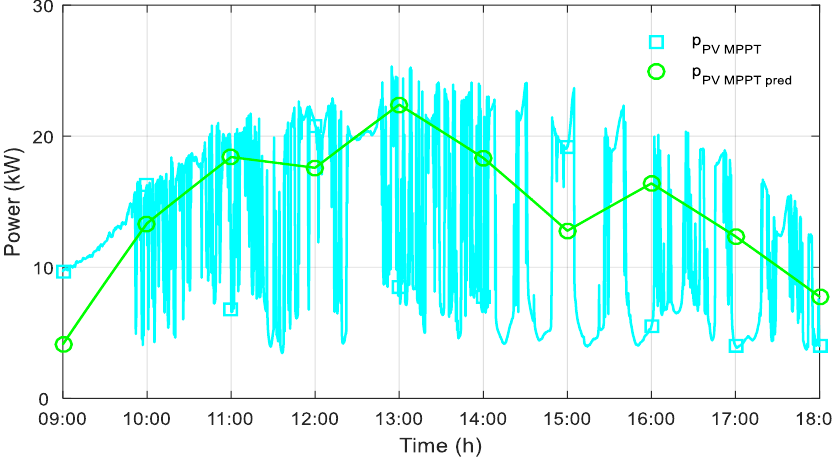
Figure 13. PV MPPT real and predicted powers and IIREV demand power—case 3.